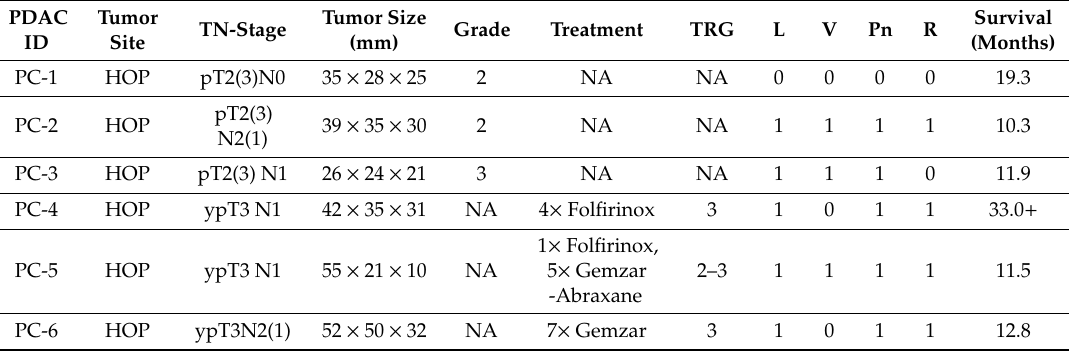
Table 1. Clinicopathological features of source pancreatic adenocarcinoma (PADC)